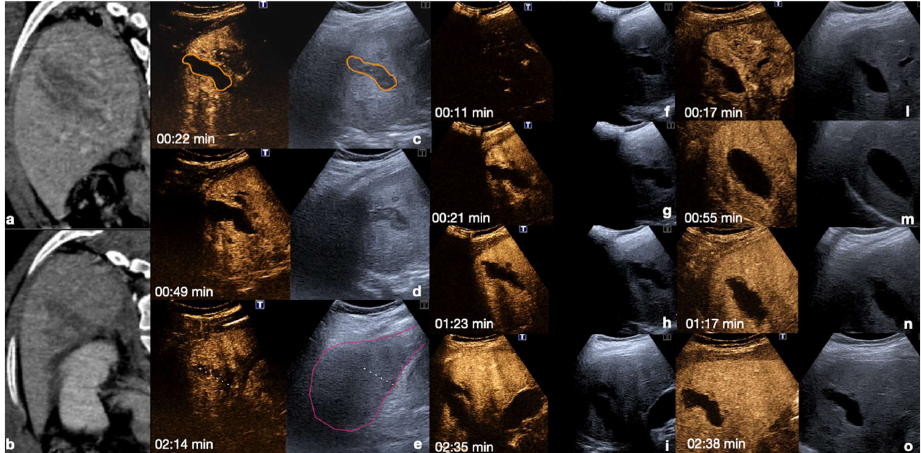
Figure 14. Admission CT ( a , b ) and follow-up CEUS ( c – o ) of a 35 − year-old blunt trauma patient with multiple hepatic lacerations. Follow-up CEUS was performed 3 days ( c – e ) , 11 days ( f – i ) , and 20 days ( l – o ) after the admission CT. Note at CEUS the progressive enhancement of the liver parenchyma in the different phases. The parenchymal lacerations appear as non-enhancing bands ( c , orange line), some of them reaching the liver capsule (pink line) ( e , i ) . In the follow-up, it is important to look for possible vascular injuries (absent in this case) in the early arterial phase ( f , l ) . Parenchymal lacerations appear progressively better demarcated, and more hypoechoic. Figure 14 is reprinted with permission from Iacobellis F.., Acampora C, Ponticiello C., Stavolo C., Scuderi M.G., Cinque T., Pinto A., Gagliardi N., Romano L. Technique and advantages of contrast-enhanced ultrasound versus MDCT in the follow-up of solid organ injuries. Electronic Presentation Online System Adopted from ref. [30], 2021, Iacobellis, F.; et